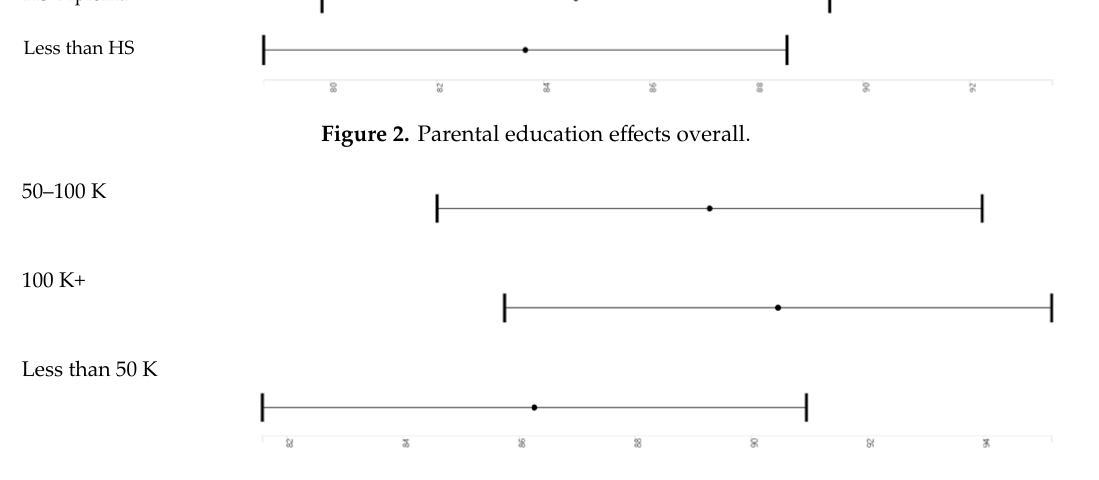
Figure 3. Income e ff ects overall.